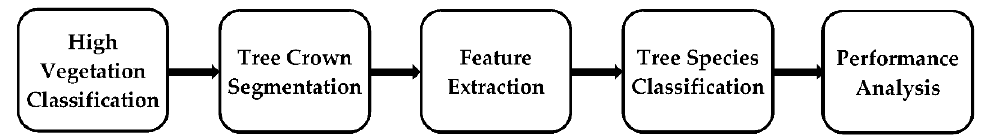
Figure 3. Block diagram of proposed machine learning-based classification of urban tree species using SVM, RF, and MLP